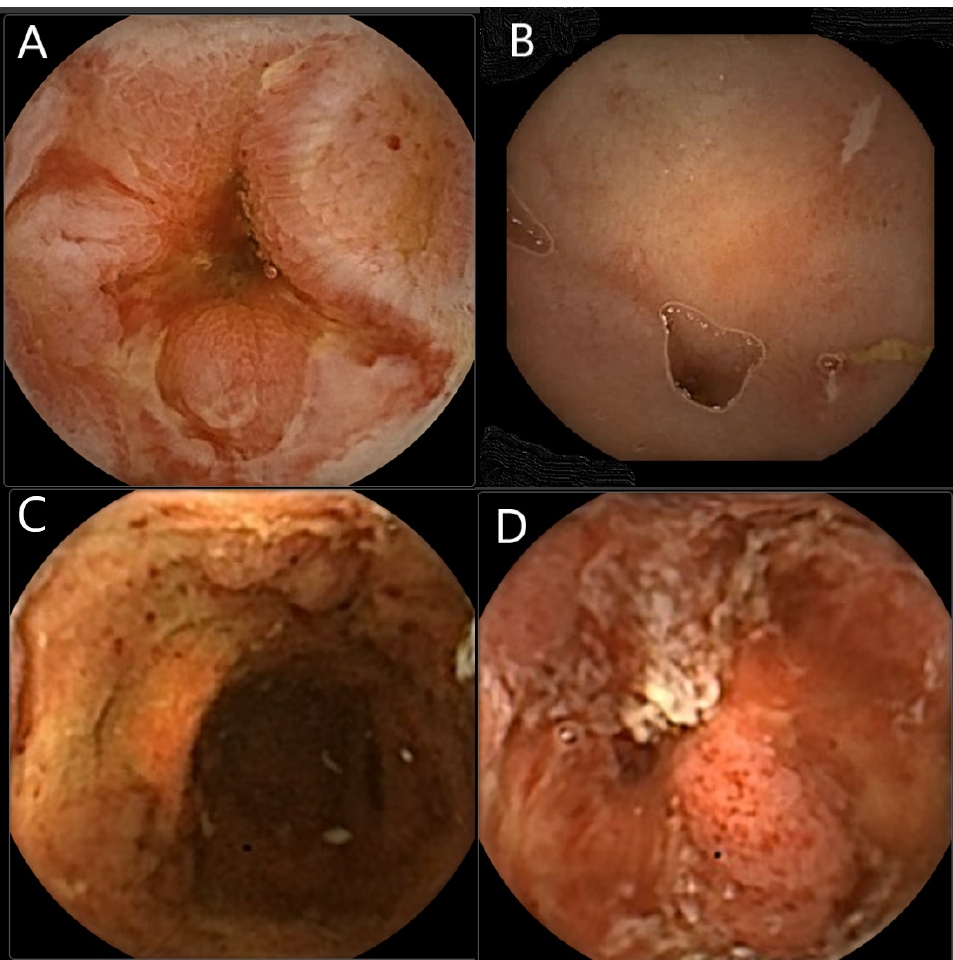
Figure 1. CCE-2 images of patients with IBD. ( A ) Small bowel Crohn’s disease with inflammatory structuring. ( B ). Small bowel Crohn’s disease with typical linear ulcers. ( C , D ). Ulcerative colitis.